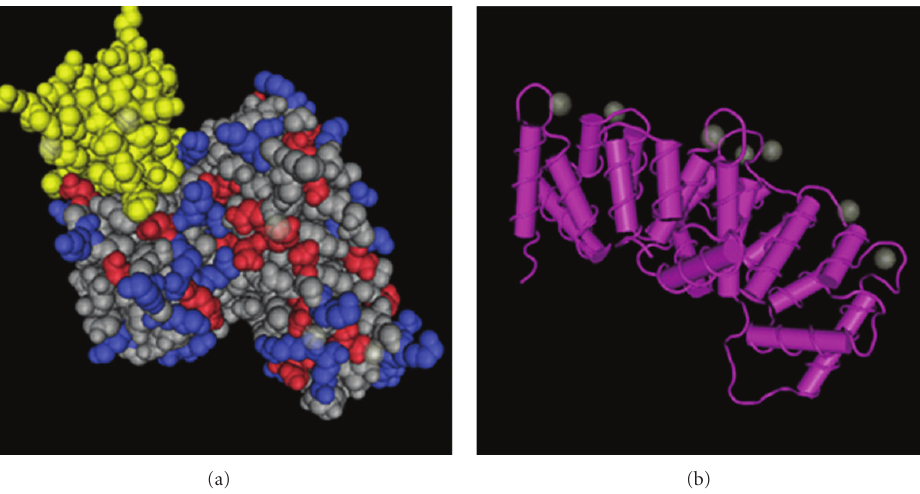
Figure 1: Structure of AnxA2. (a) Space filling view of AnxA2 (colours indicate hydrophobicity) looking “down” onto the membrane- binding surface of the molecule. One endonexin fold, repeated four times in AnxA2, is highlighted in yellow. (b) “Cartoon” of AnxA2 showing the molecule from the side. The protein is almost entirely made up of alpha-helices. The position of coordinated calcium atoms is shown in